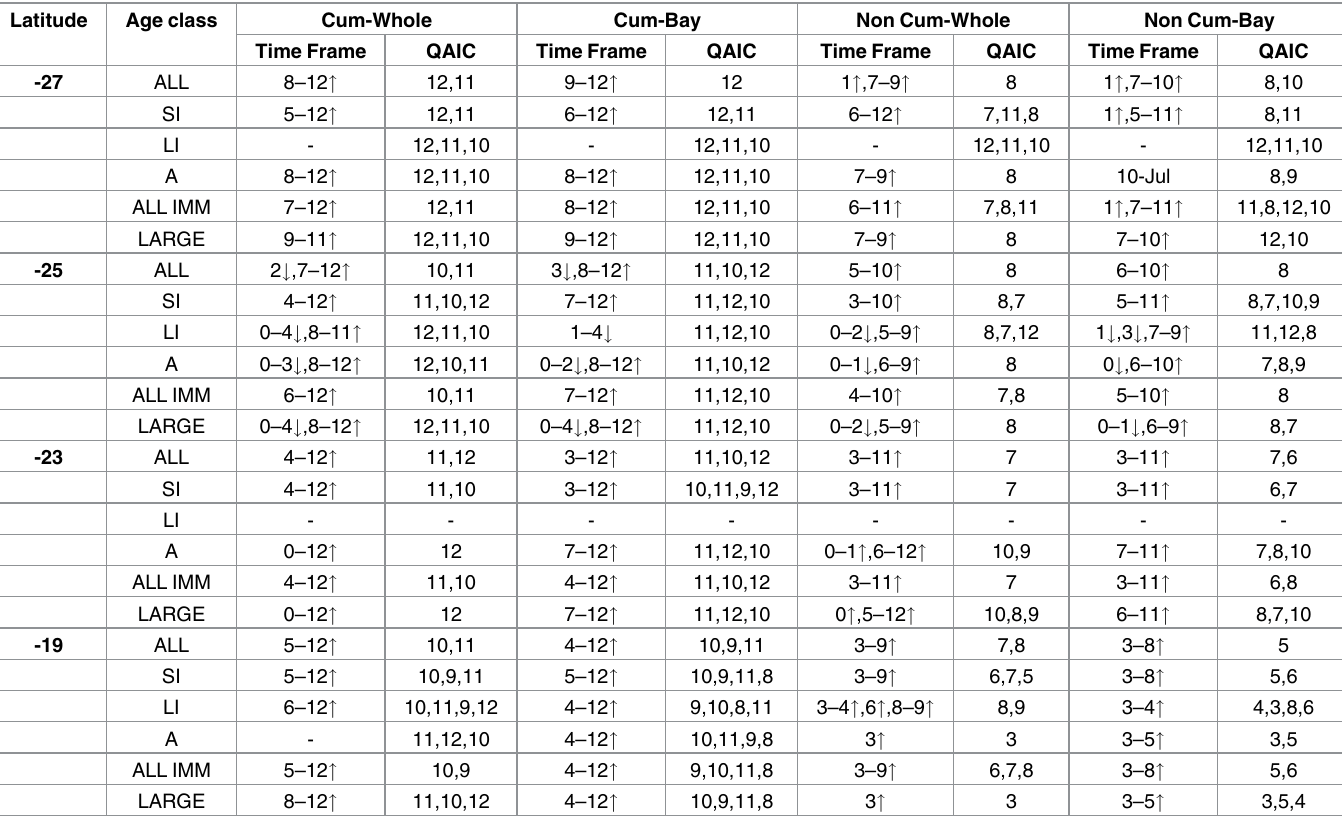
Table 10. Model results for all turtles and cumulative mean discharge. " denotesincreasedstrandingsrates with increaseddischarge. # denotes decreased strandingrates with increaseddischarge. Age class abbreviations: ALL = all turtles, SI = small immature, LI = large immatures, A = adult-sized, ALL IMM = all immature sized animals(small + large), Large = all large turtles (large immatures + adult-sized). The time frame is reportedin monthly ranges where responseswere noted. The values reportedin qAIC are the months with the most significantqAIC